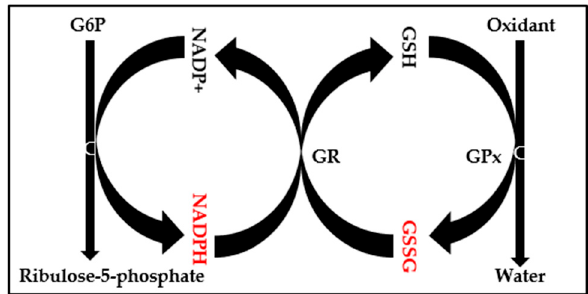
Figure 2. The oxidative branch of the PPP is a major supplier of NADPH for glutathione recycling. The reduction of glutathione (GSH) disulfide to glutathione via glutathione reductase needs NADPH to be completed. Thus, oxidized glutathione (GSSG):GSH and NADPH:NADP+ ratios are impaired due to oxidative stress.